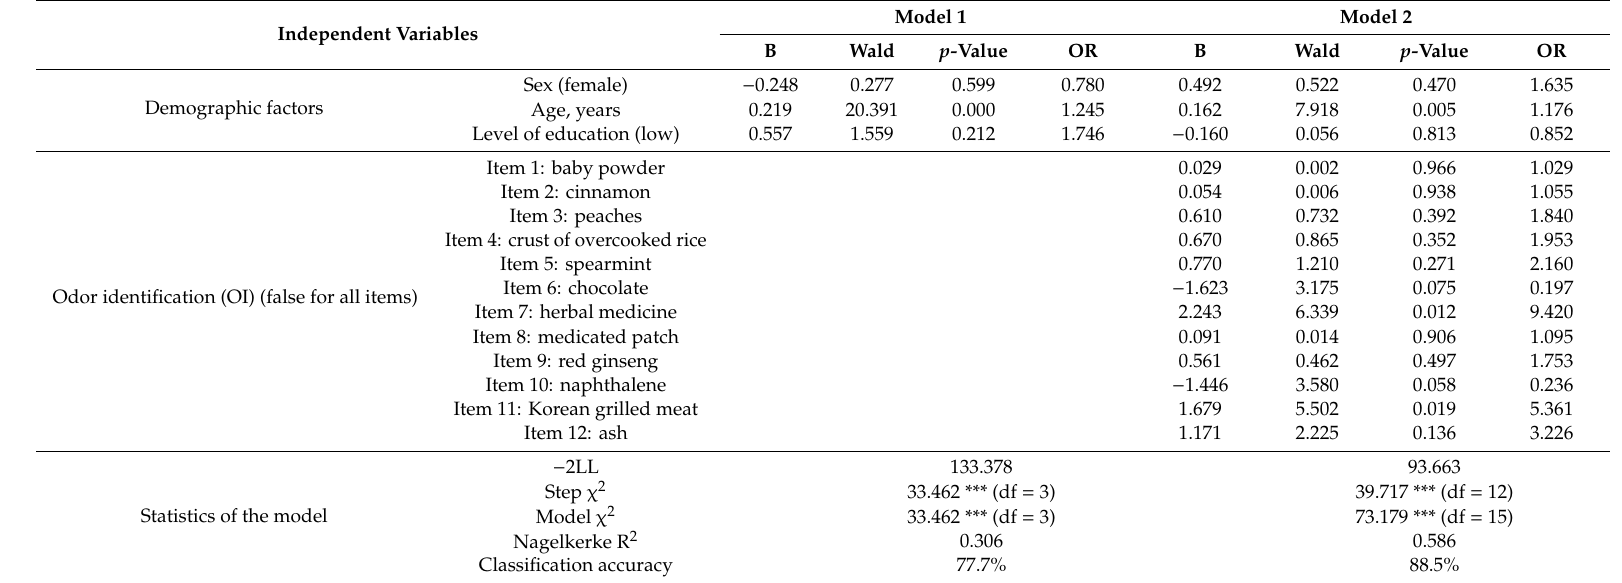
Table 3. Results of hierarchical logistic regression analyses with diagnosis of dementia as a dependent variable for the normal cognition ( n = 99) and dementia ( n = 40)